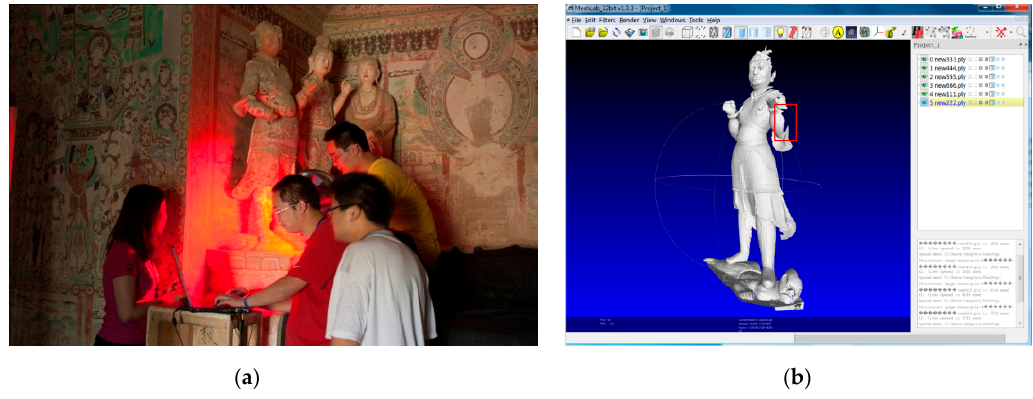
Figure 10. Illustration of fieldwork and software interface of inspection, ( a ) on-site scanning, ( b ) field inspection (red box denotes the detected area with issues).